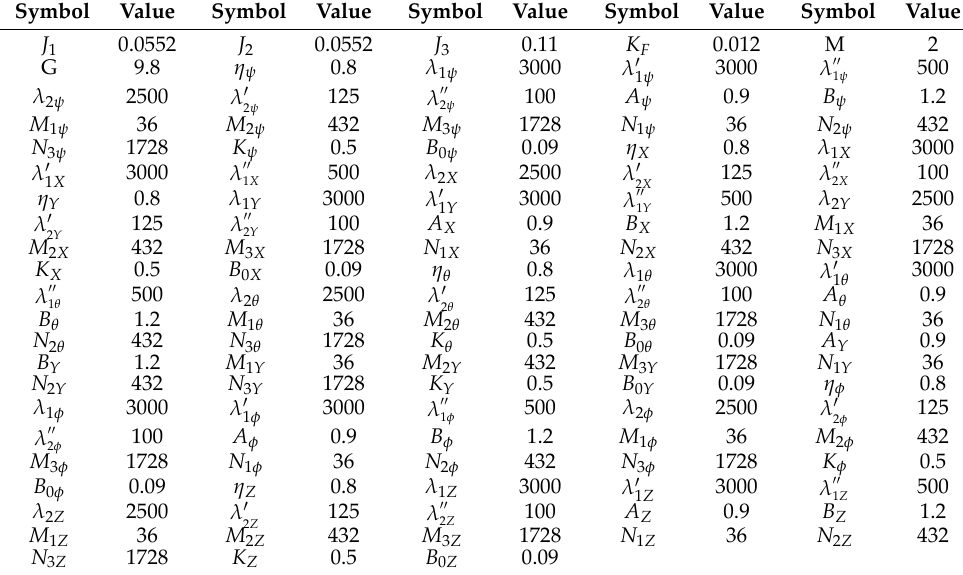
Figure 6. The curve of the disturbance in Yaw angle channel.